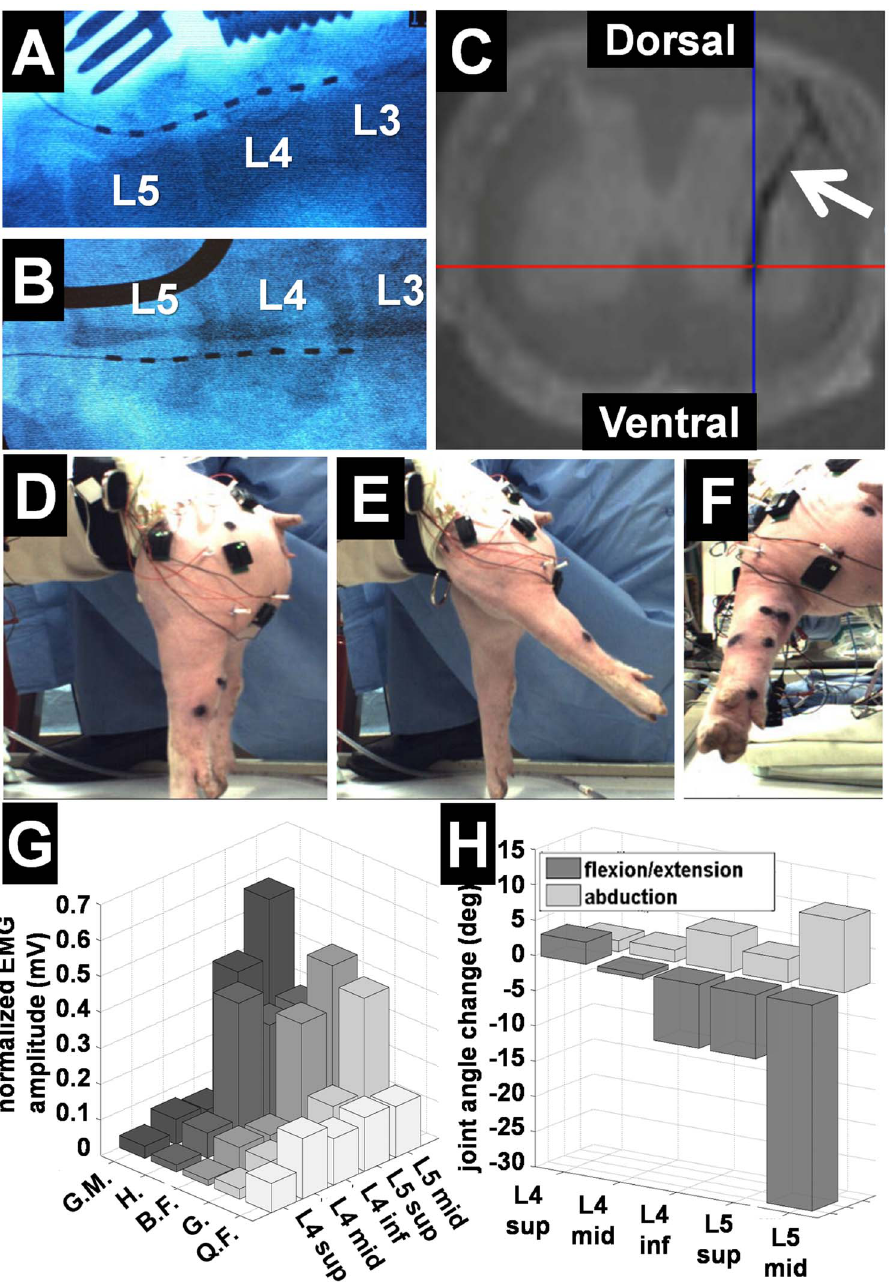
Figure 2. Targeting analysis and functional outcomes. ( A ) Epidural electrode placement confirmed by lateral intra-operative fluoroscopy; ( B ) Posterior-anterior intra-operative fluoroscopy; ( C ) Ex-vivo axial MRI of spinal cord showing ISMS electrode tract (arrow); ( D ) Experimental setup for kinematic analysis; ( E–F ) Typical hip extension evoked by ISMS at L5-segment; ( G ) Normalized intramuscular EMG amplitude as a function of spinal cord segment evoked by ISMS at 300 m A (n=3); ( H ) Kinematic analysis of joint angle change evoked by ISMS as a function of spinal cord segment (n=3). Abbreviations: G.M.=Gluteus medius, H=Hamstrings, B.F.=Biceps femoris, G=Gastrocnemius, Q.F.=quadriceps femoris.